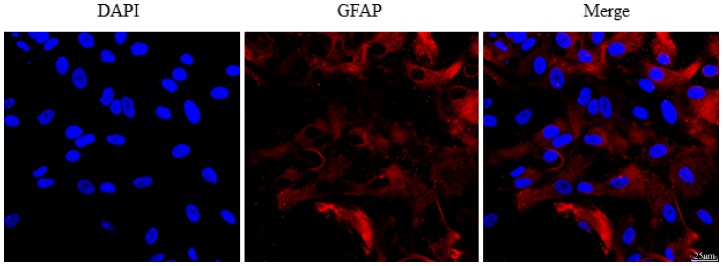
Identification of cultured rat astrocytes by immunofluorescence staining for glial fibrillary acidic protein (GFAP) and 4′,6-diamidino-2-phenylindole (DAPI).About 98% cells are GFAP-positive.